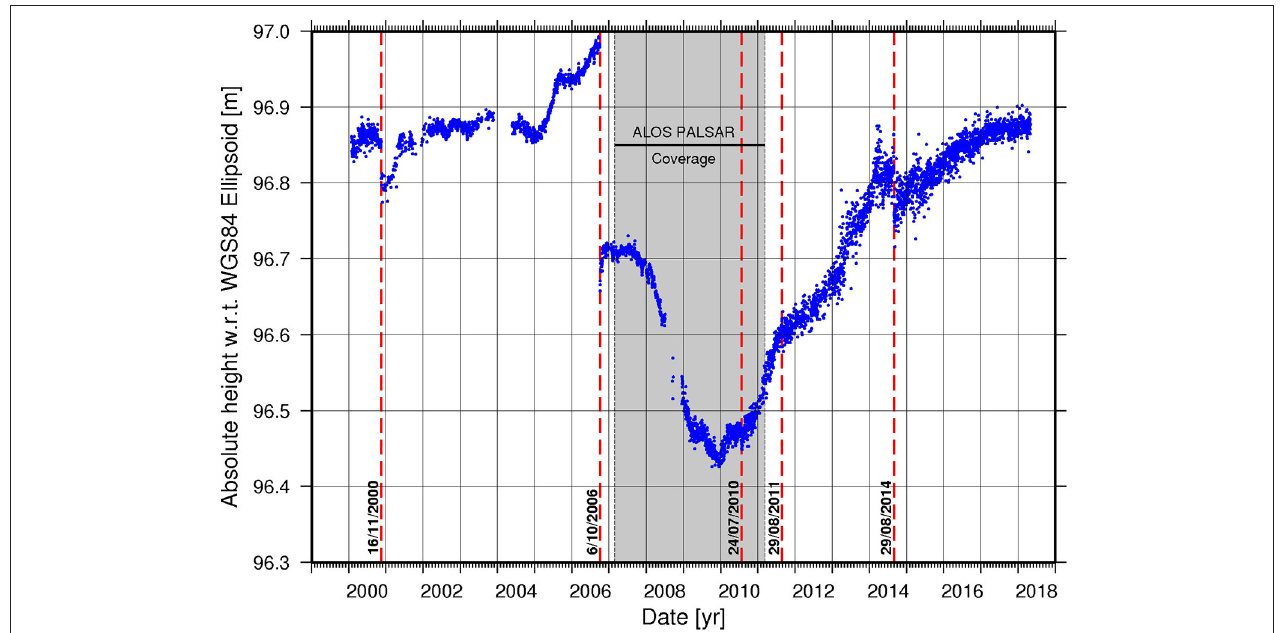
FIGURE 3 | Record of absolute height change (with respect to the WGS84 Ellipsoid) at Matupit derived from RVO’s daily processing of GNSS observations at station “SDA” since January 2000. The red-dashed lines mark dates where significant events occurred (described in Table 3 ).